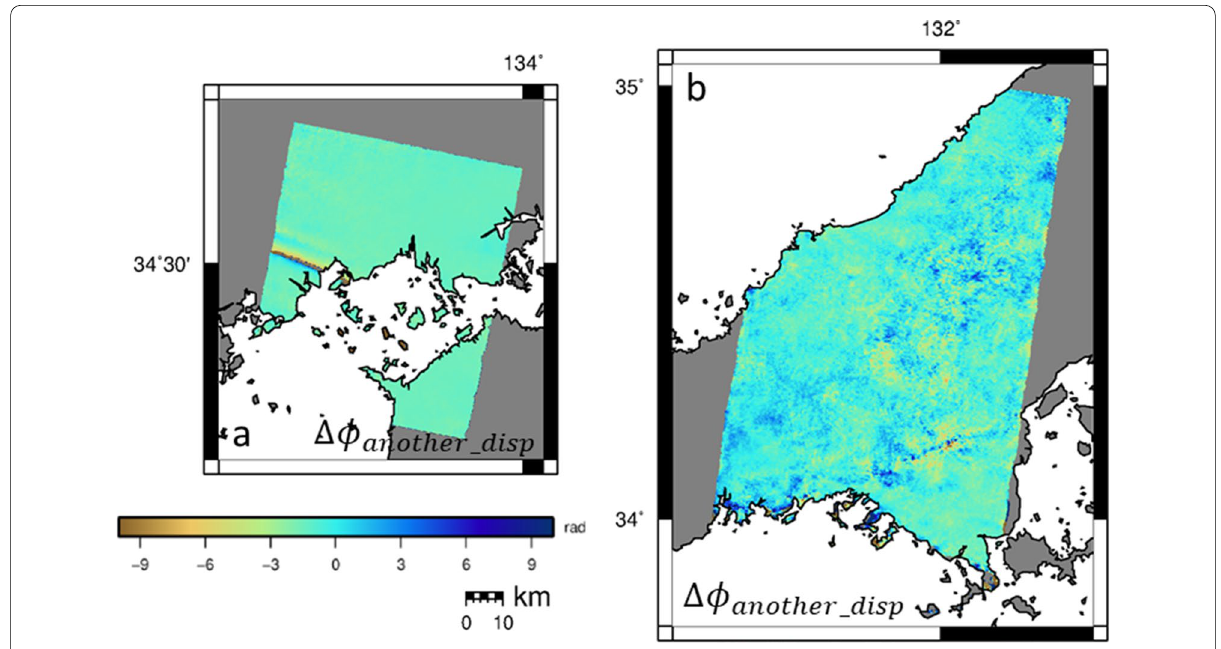
Fig. 11 �φ another_disp inferred from Sporadic-E images on ( a ) 20160217_20160525 and ( b ) 20090328_20090628 reported by Furuya et al.